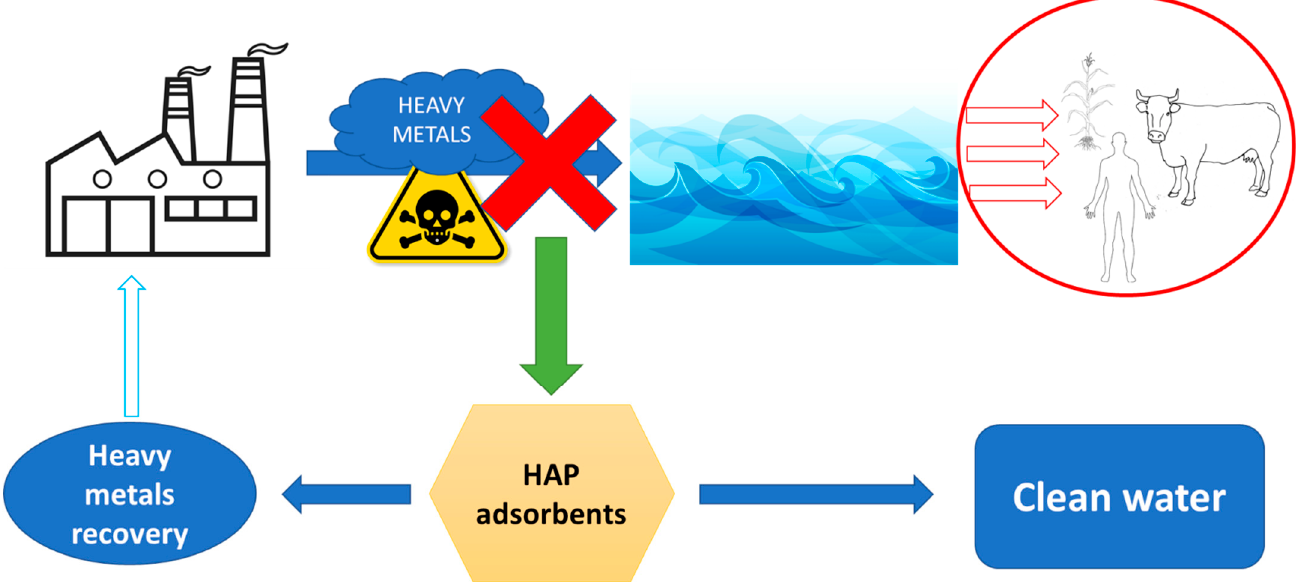
Figure 2. Fate of heavy metals in the environmental and the application of HAP adsorbents for their removal from ecosystems and recovery/reuse.